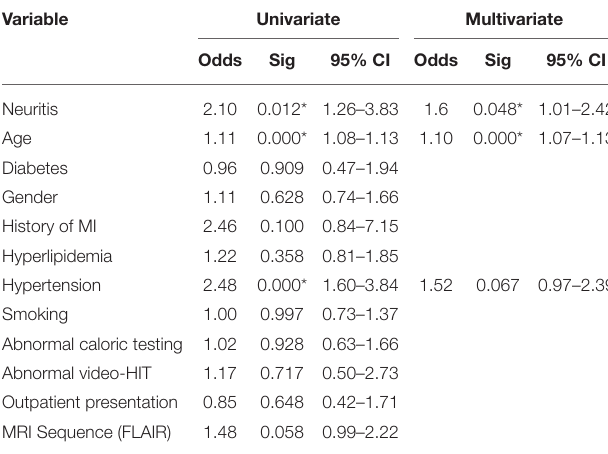
TABLE 2 | Ordinal regression